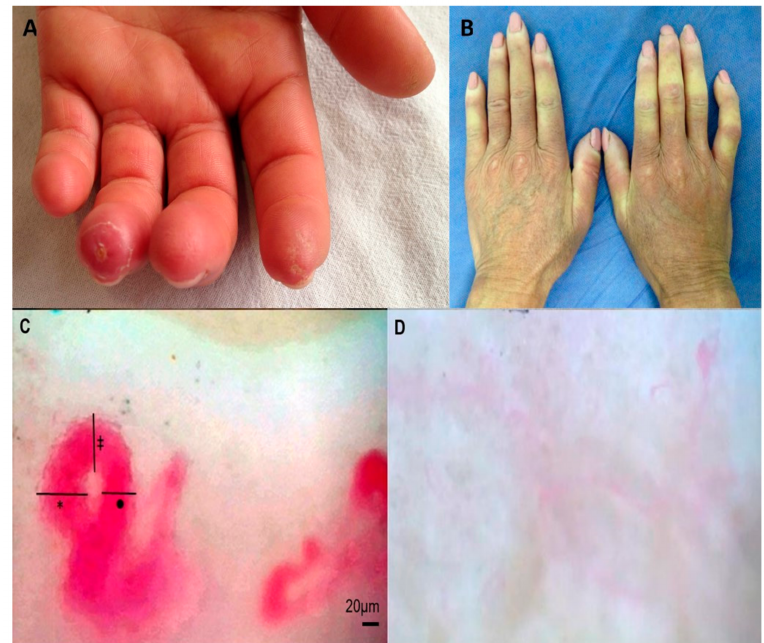
Figure 1. Clinical and NFC assessment. Clinical and capillaroscopic features were assessed in the study population. A representative patient with fingertip scars ( A ). A patient Raynaud’s phenomenon at examination ( B ). NFC in one of the cases included in the study, schematic representation of capillary diameters assessed in all individuals in nailfold capillaroscopy (*) arterial limb, ( • ) venous limb and (‡) top diameters are shown ( C ). NFC was evaluated in all individuals and classified in “early”, “active” or “late” patterns (Scleroderma patterns) or “normal” capillaroscopy; a case of “late” pattern shows severe capillary loss with wide avascular areas and severe disorganization of the normal capillary array ( D ). NFC: nailfold